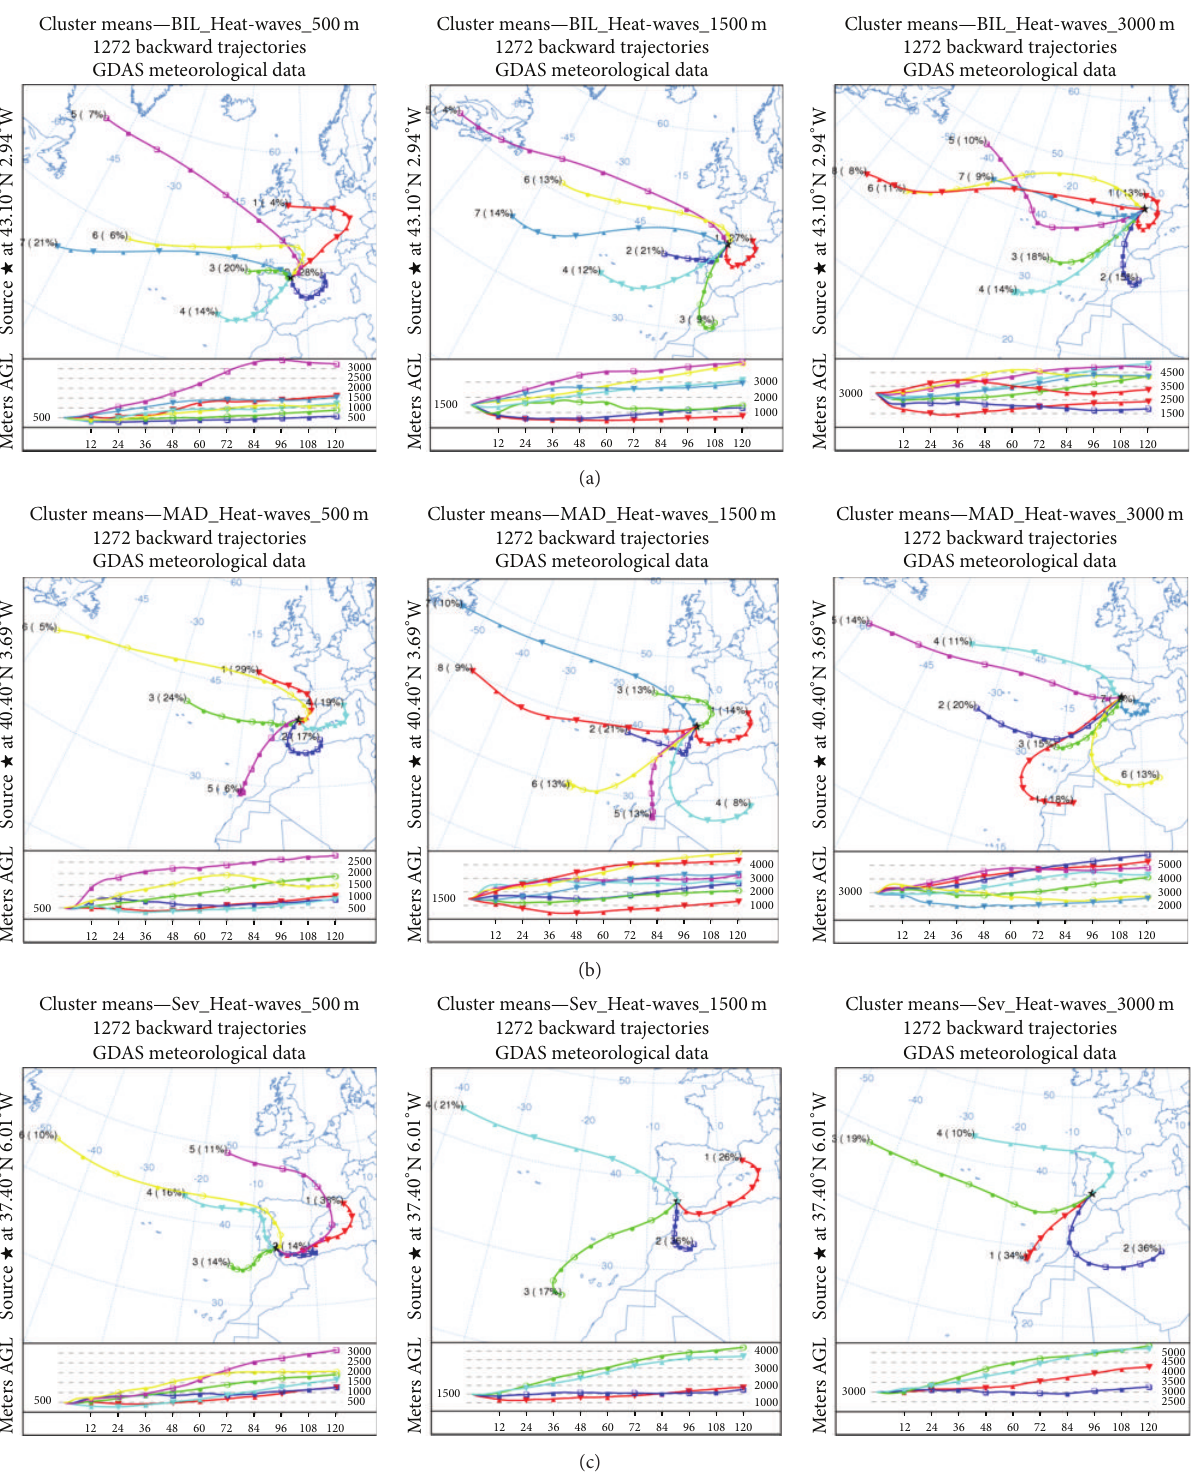
Figure 4: Centroids of the backward trajectories (vertical profile and horizontal pathways) at (a) Seville, (b) Madrid, and (c) Bilbao at 500 m, 1500 m, and 3000 m during the whole set of heat-wave